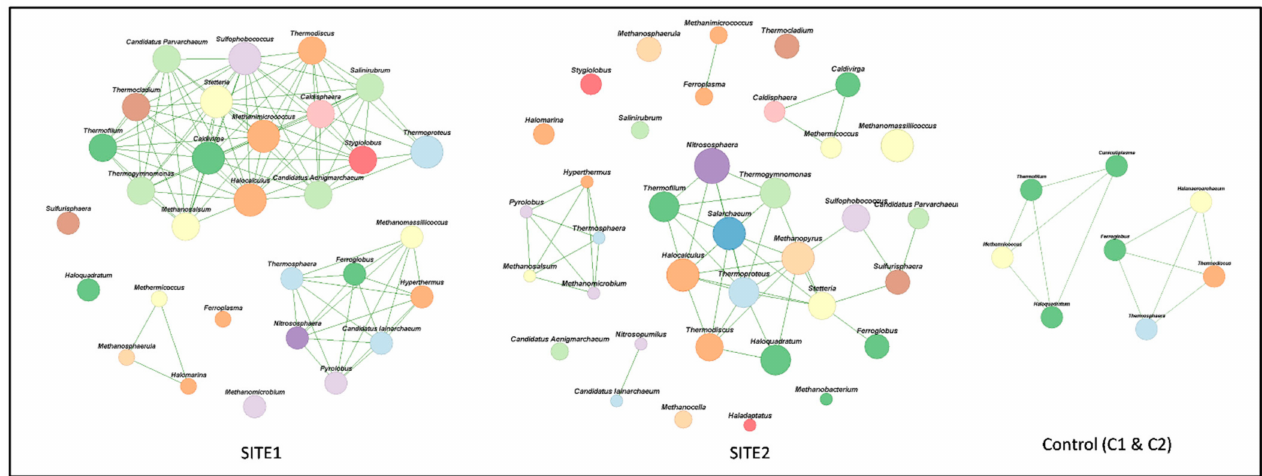
Figure 2. Co-occurrence networks from SITE1, SITE2 and agricultural soil samples. The networks were based on archaeal OTUs. Green lines indicate positive co-occurrence. Image was constructed in MEGAN [33] using Jaccard correlation coefficient with an edge threshold of